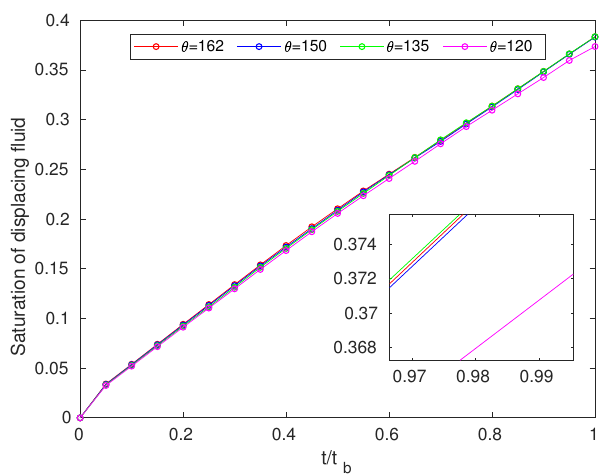
Figure 10. Evolution of the displacing fluid saturation for contact angles of 162 ◦ , 150 ◦ , 135 ◦ , and 120 ◦